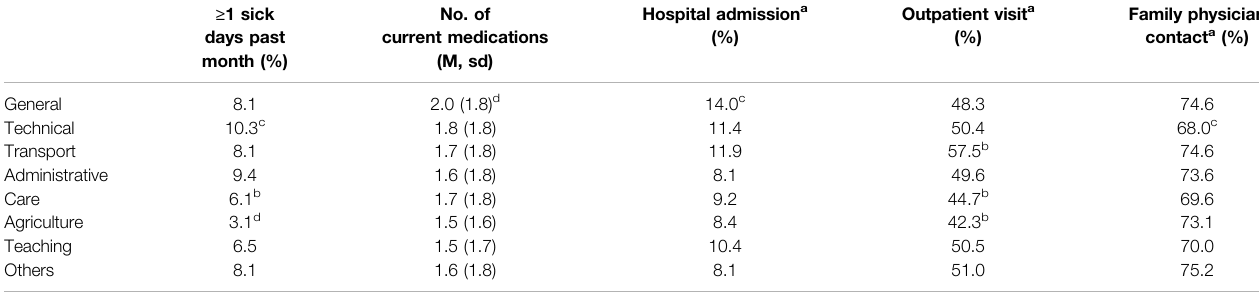
TABLE 2 | Key health characteristics of the occupational domains selected. Source: Longitudinal Aging Study Amsterdam, 1992 – 93 ( n (cid:1) 2,531). ≥ 1 sick days past